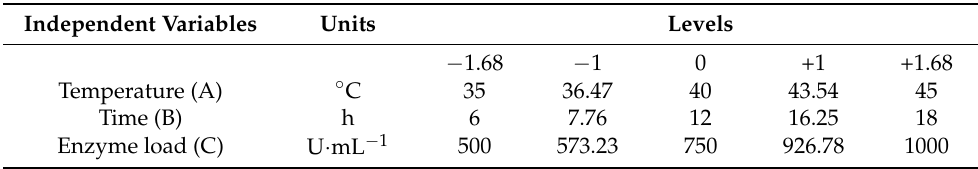
Table 1. Coded and uncoded variables of the response surface design for Beauveria bassiana SAN01 xylanase-assisted paper deinking. Independent Variables Units